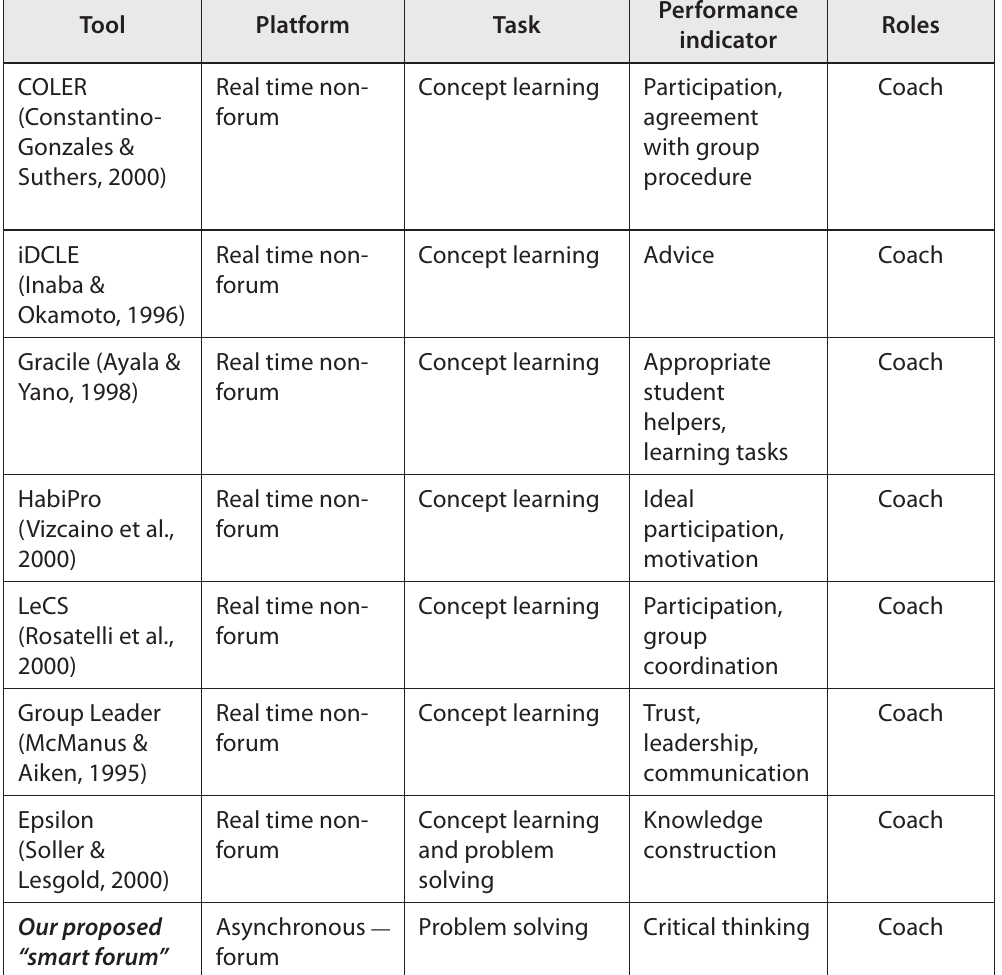
Source: Adapted from Soller et al.,